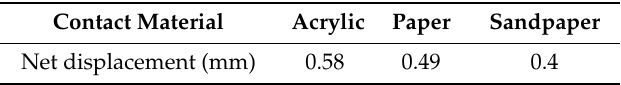
Table 2. CR displacements measured under di ff erent contact